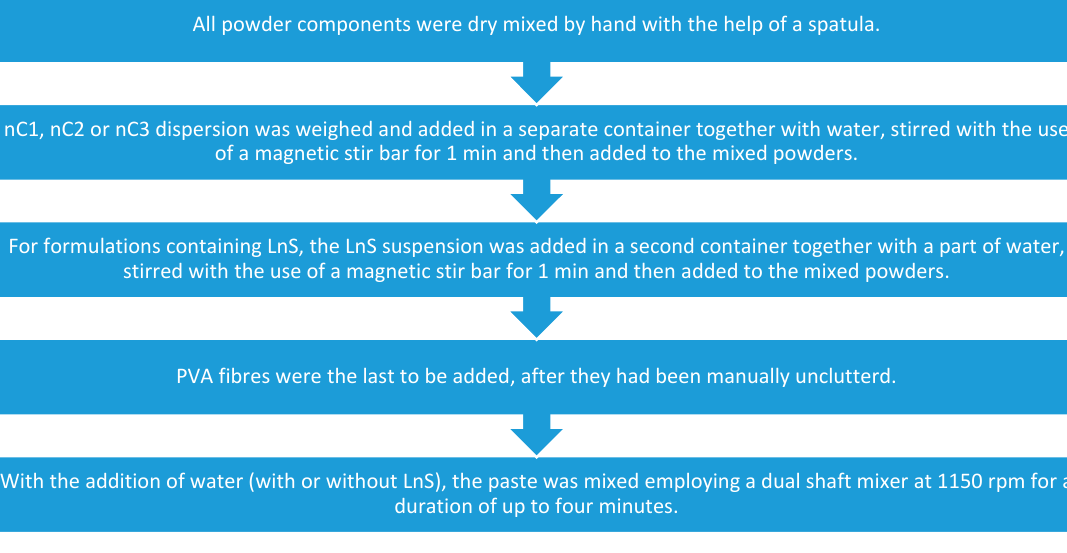
Figure 3. Flow chart of the mixing procedure.